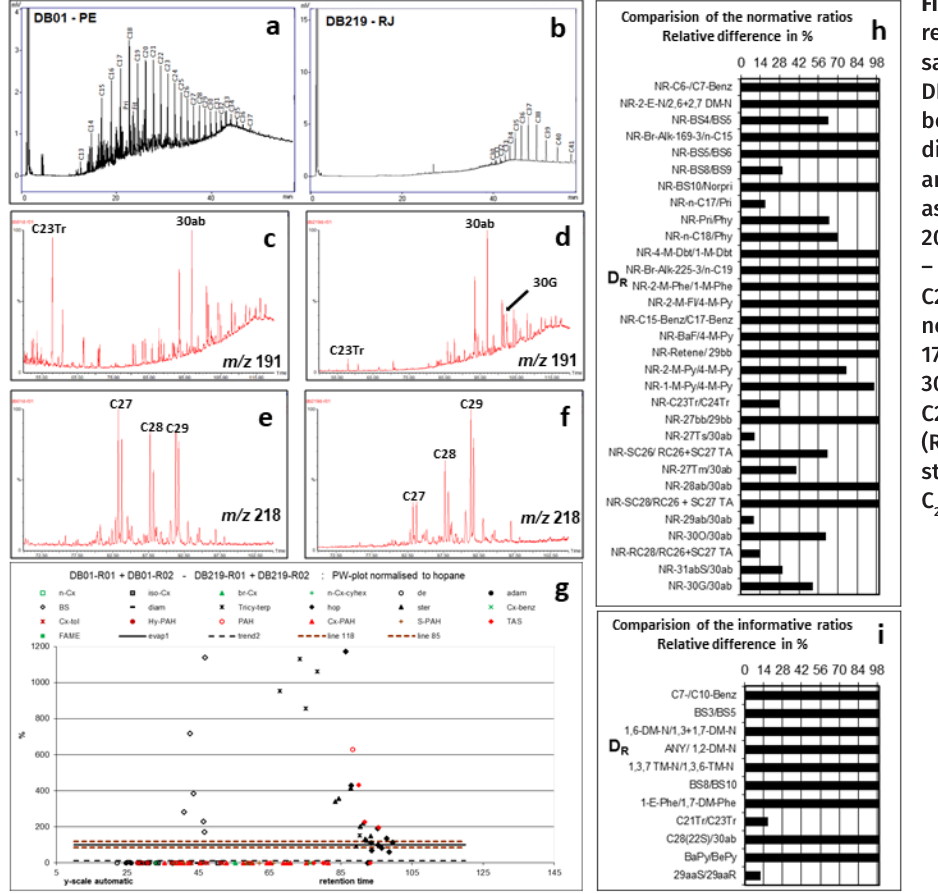
Figure 10. Combined results between samples DB01 and DB219, indicating that both samples are from different sources (DRs and compound